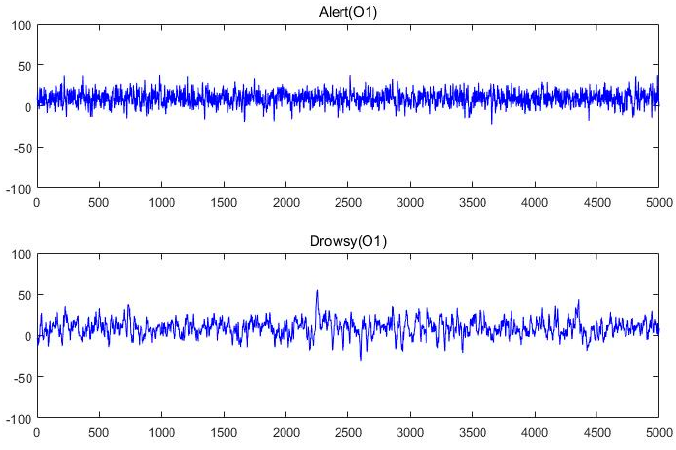
Figure 13. Raw EEG signal in alert and drowsy states from BP equipment.